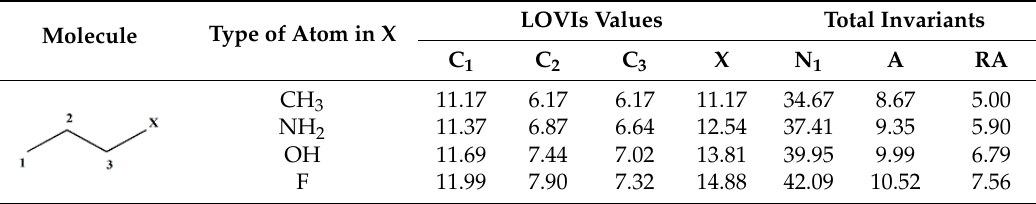
Table 4. Evaluation of some organic molecules with heteroatoms. Molecule Type of Atom in X